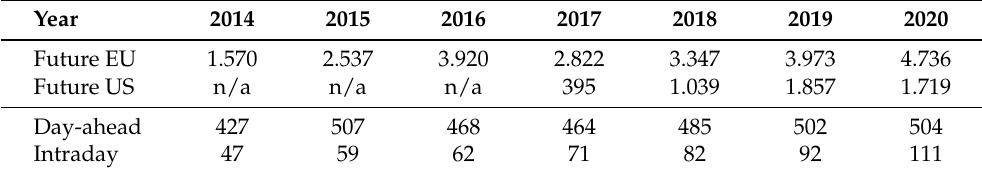
Table 1. Historical trading volumes on European Electricity Exchange EEX and EPEX in TWh